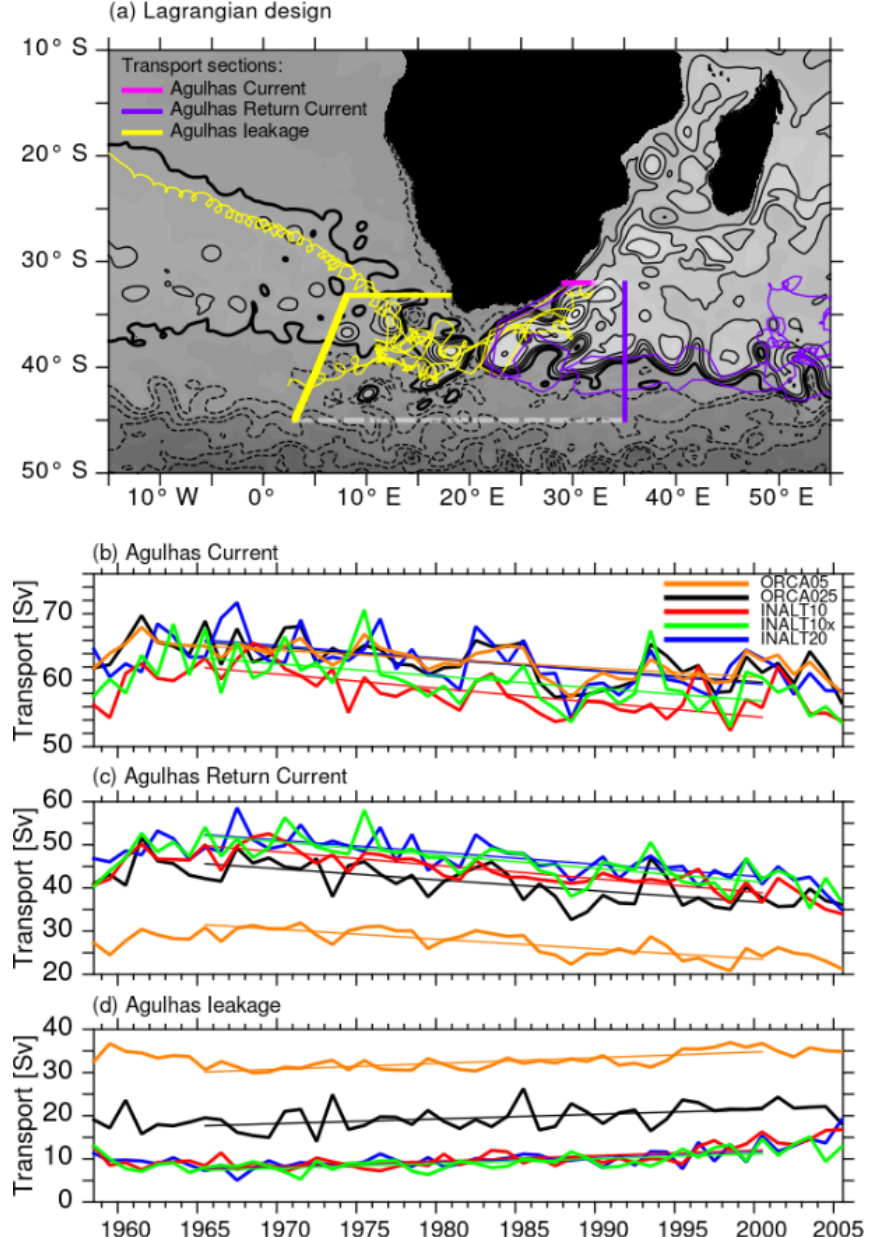
Figure 16. Lagrangian design (a) and transport time series (in Sv) of the Agulhas Current ( b ; transport across the magenta line in panel a ), Agulhas Return Current ( c , transport across the purple line in panel a ) and leakage ( d , transport across the yellow line in panel a ) from the Lagrangian experiments. The shading and contours in panel (a) are a snapshot of SSH as simulated in INALT20. The yellow and purple trajectories indicate exemplary paths from the release to the sampling